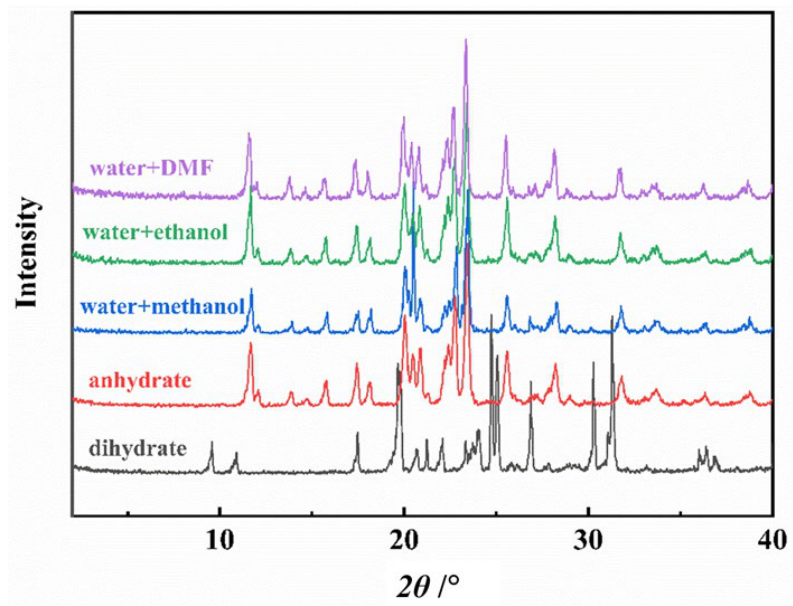
Figure 3. Powder X-ray diffraction pattern of dried solid in mixed systems: water + DMF ( x w = 0.648), water + ethanol ( x w = 0.447) and water + methanol ( x w = 0.360) at T = 298.15 K.